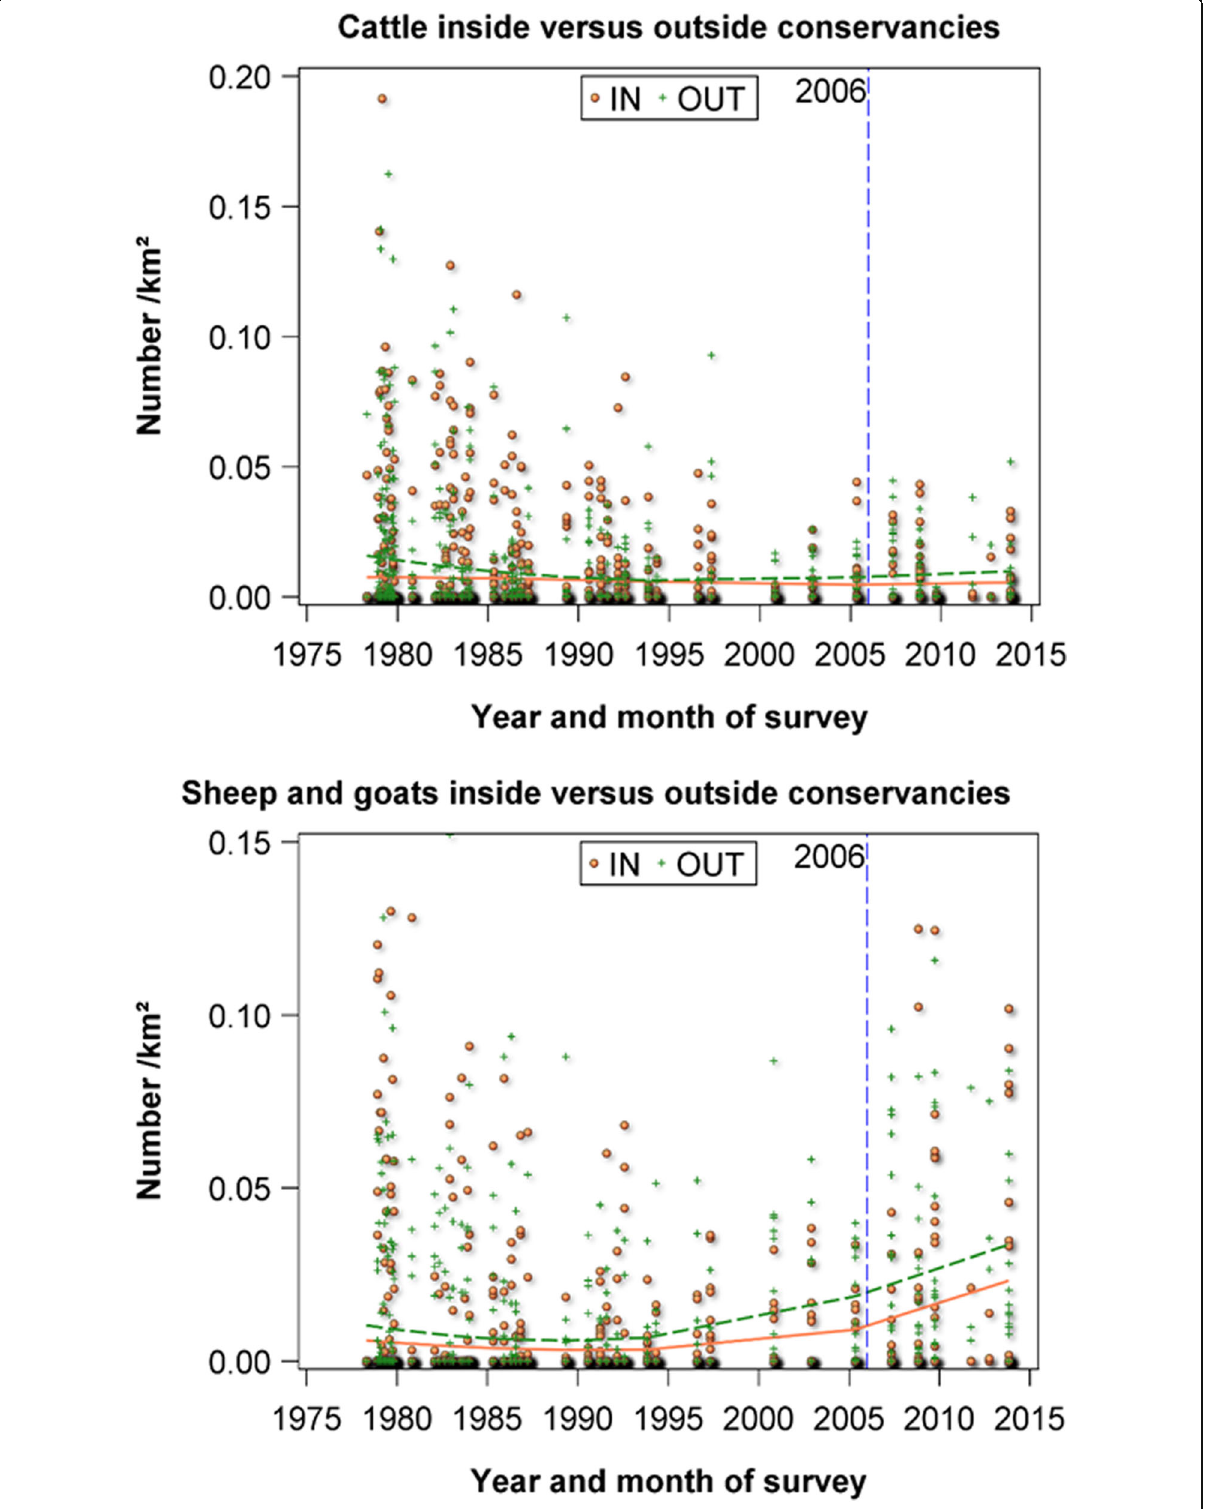
Figure 8 Trends in cattle and shoat density, inside and outside of conservancies, 1977 to 2014, Koyiaki Group Ranch. Figure note: Coral circles and solid lines denote inside conservancies and forest green triangles and dashed trend lines outside conservancies. The dashed blue line indicates when conservancies began to expand in number and size in